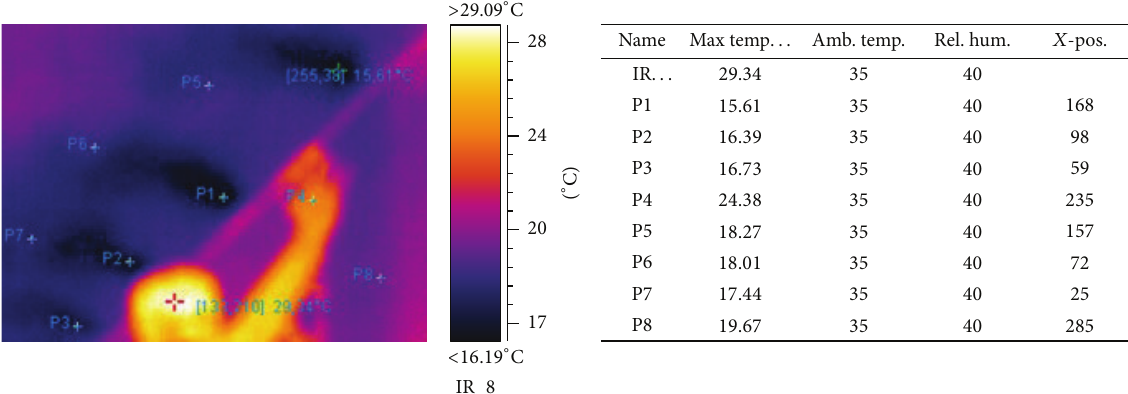
Figure 11: The thermal camera images and information of people raising one arm.